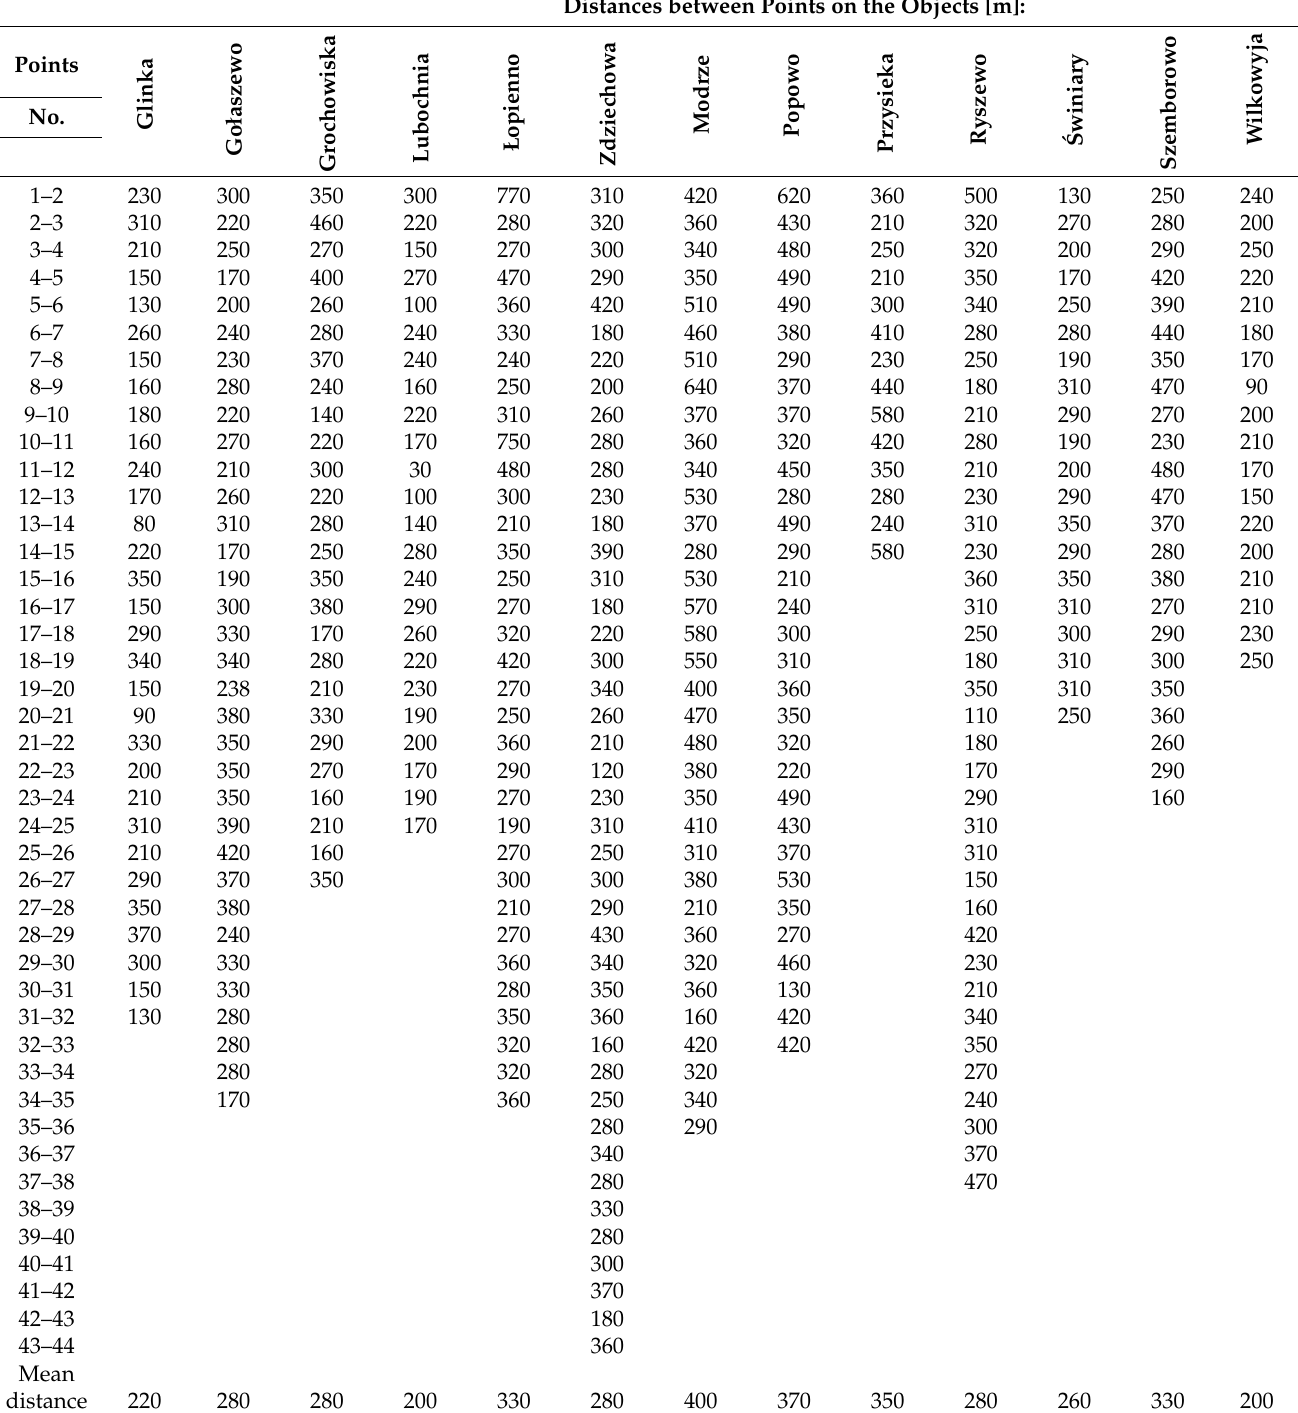
Table 1 shows the number of points for each object and the distance between successive points (calculated from coordinates). Table 1. Distance between the points designated on particular